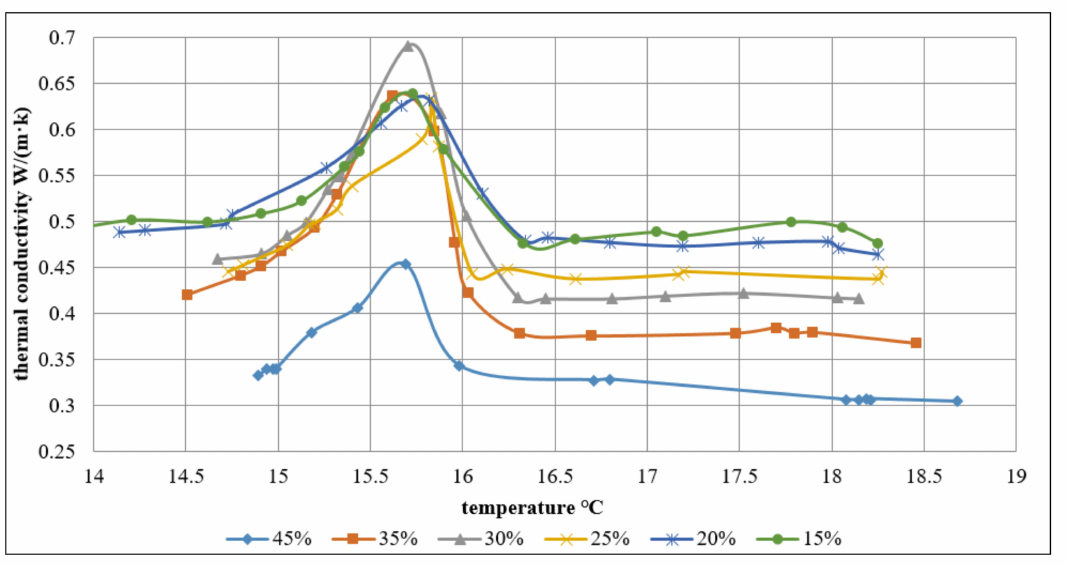
Figure 7. The variety concentration PCMs thermal conductivity with different